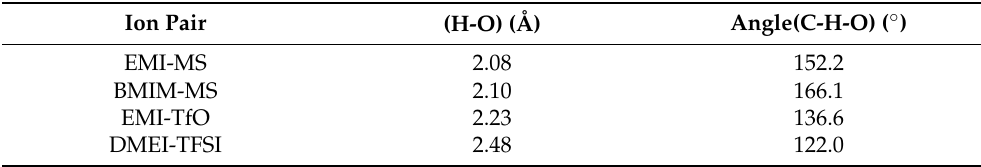
Table 1. Distance between the closest H atom of the cation and O atom of the anion and CHO angle in various ion pair calculated by DFT by the ω B97X-D functional and considering the presence of a polar